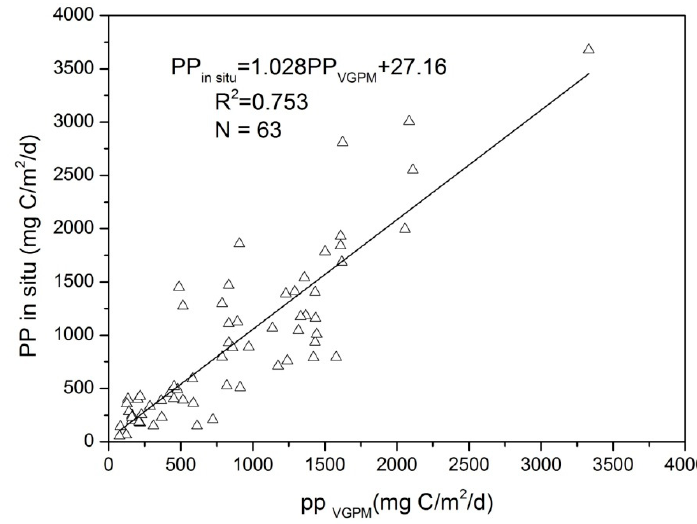
Figure 2. Relationship between measured and estimated primary production by VGPM.